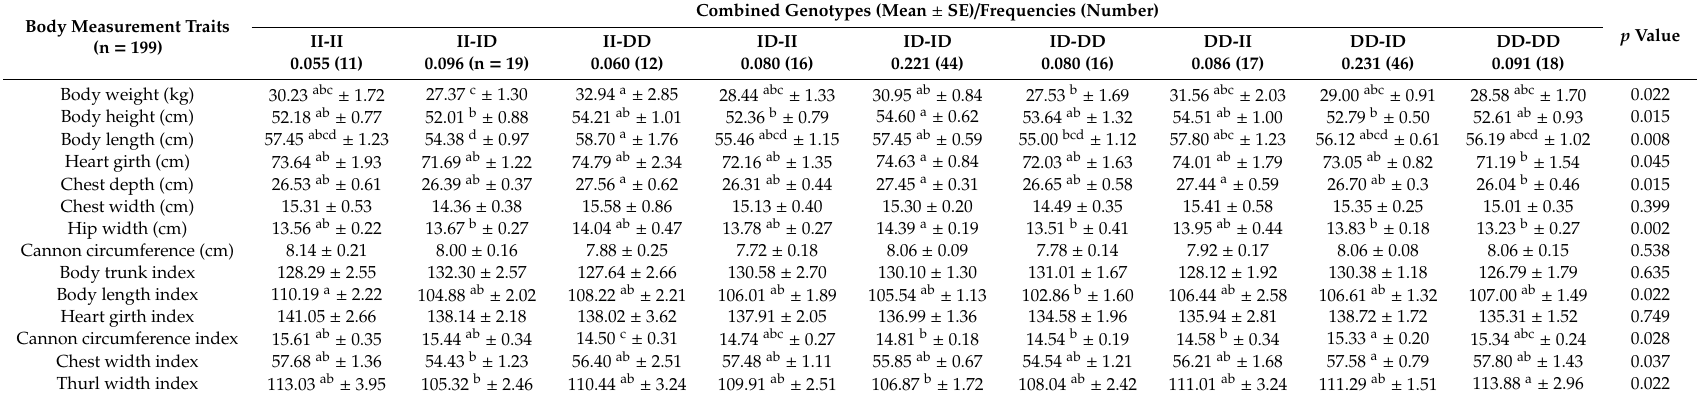
Table 6. The association of goat SPAG17 14 and 17 bp indel combined genotypes and body measurement traits of Hainan black goats. Body Measurement Traits (n =